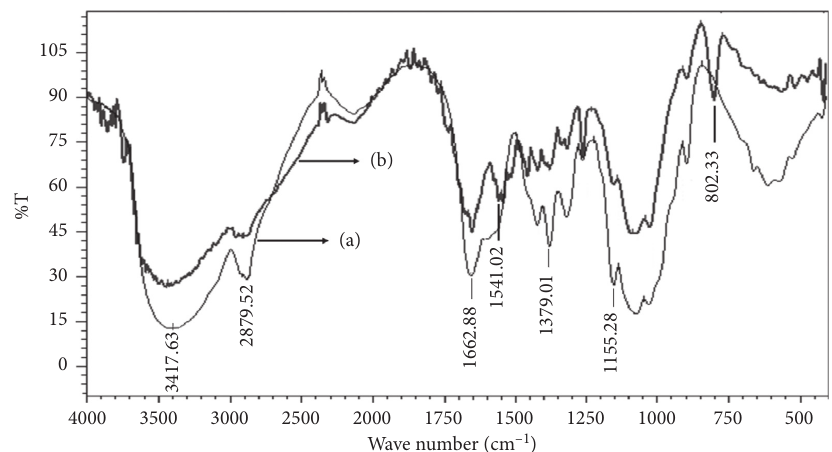
Figure 2: IR spectra of chitosan (a) and cross-linked chitosan beads (b).